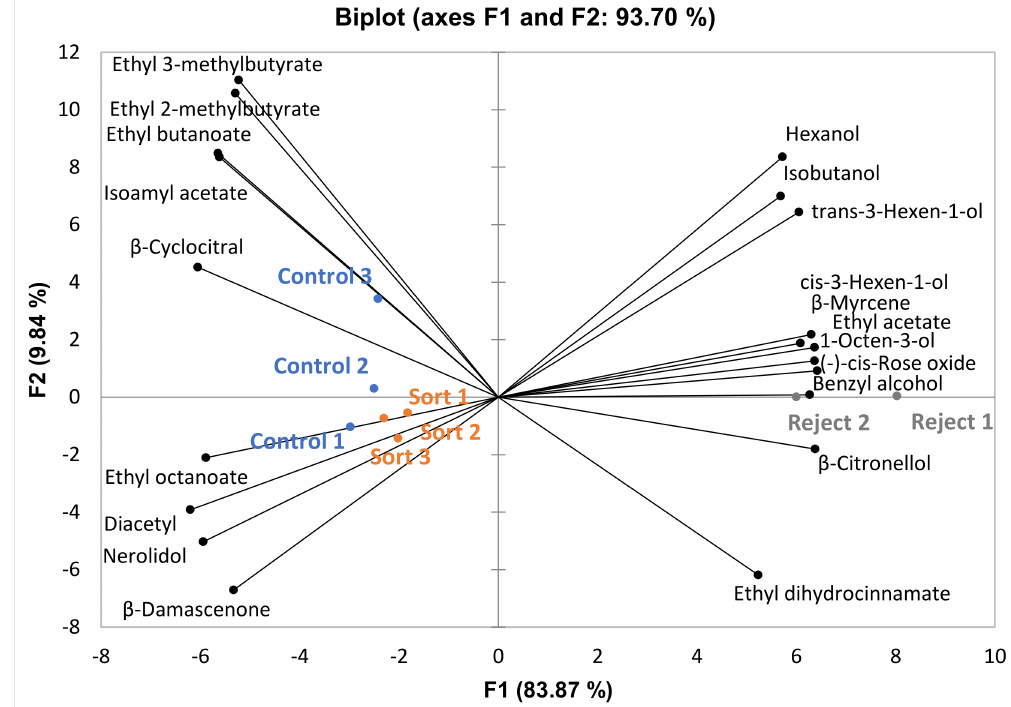
Figure 1. Principle Component Analysis (PCA) biplot of volatile compounds that differed significantly among treatments for the Cabernet Sauvignon wines ( p < 0.05, n = 3 for sort and control treatments, n = 2 for reject